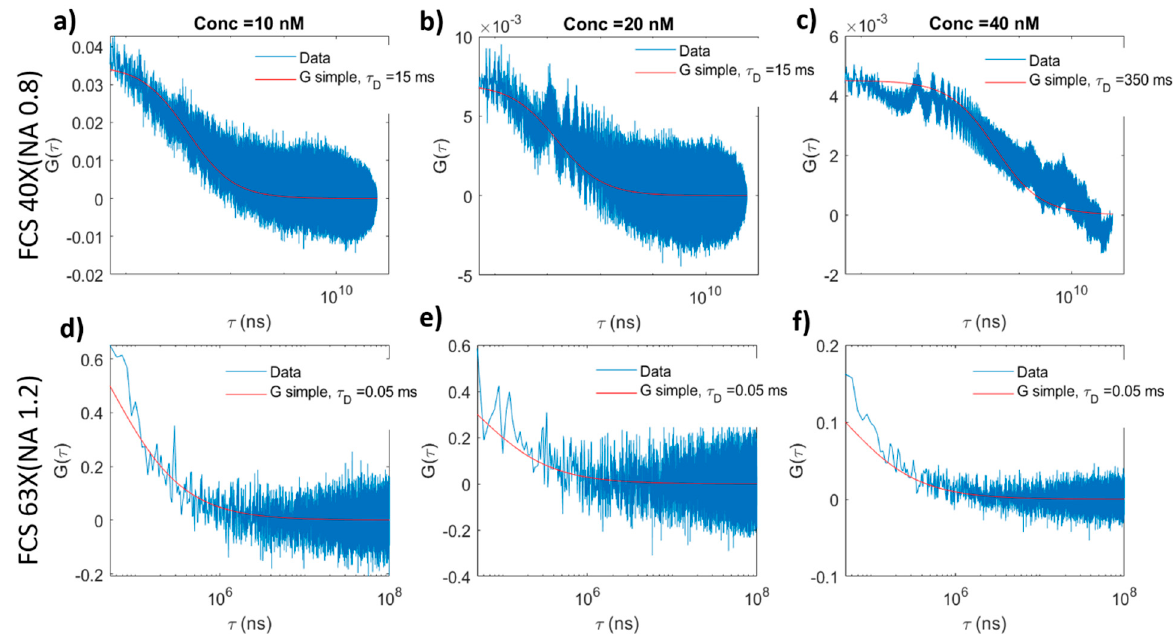
Figure 6. The effect of concentration on FCS data obtained from Rhodamine B solution at different concentrations (10 nM, 20 nM and 40 nM) generated by different objective lenses ( a – c ) 40× (NA 0.8) and ( d – f ) 63× (NA 1.2). Autocorrelation function data (blue) and fitted data (red) are shown. The data was obtained from red channel (580/150 nm) at 800 nm excitation wavelength, 25mW excitation intensity.